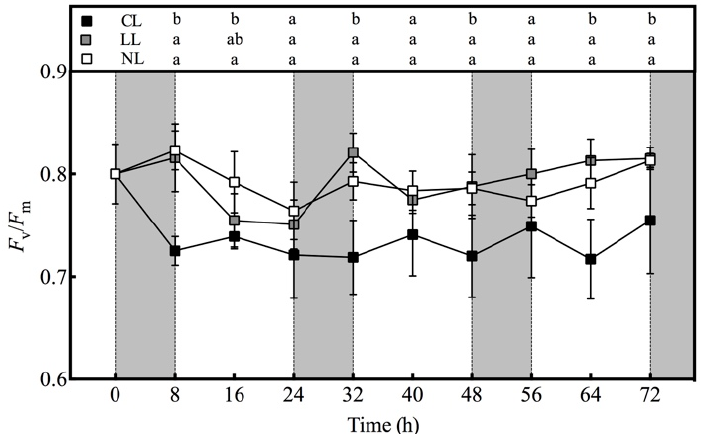
Figure 5. Effects of light intensities at night time on the Fv/Fm value of lettuce leaves under red and